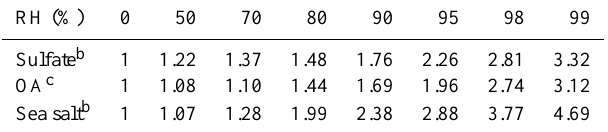
Table 2. Hygroscopicity in this model a